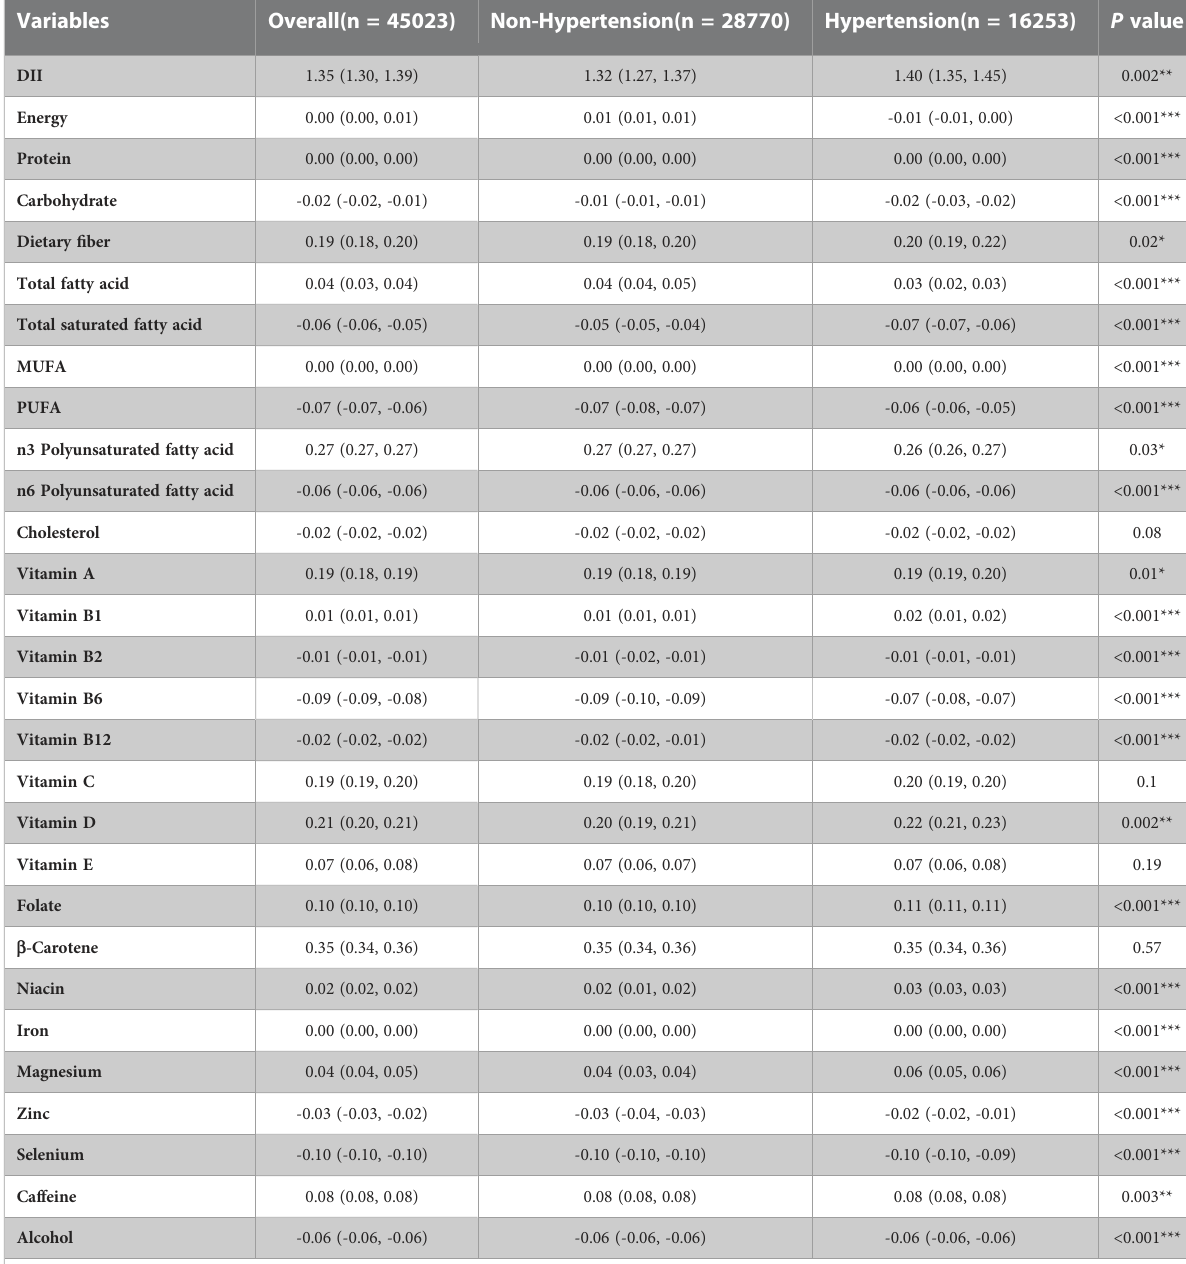
TABLE 2 Comparison of each Component of DII Scores Between Individuals with Hypertension and Individuals without Hypertension.